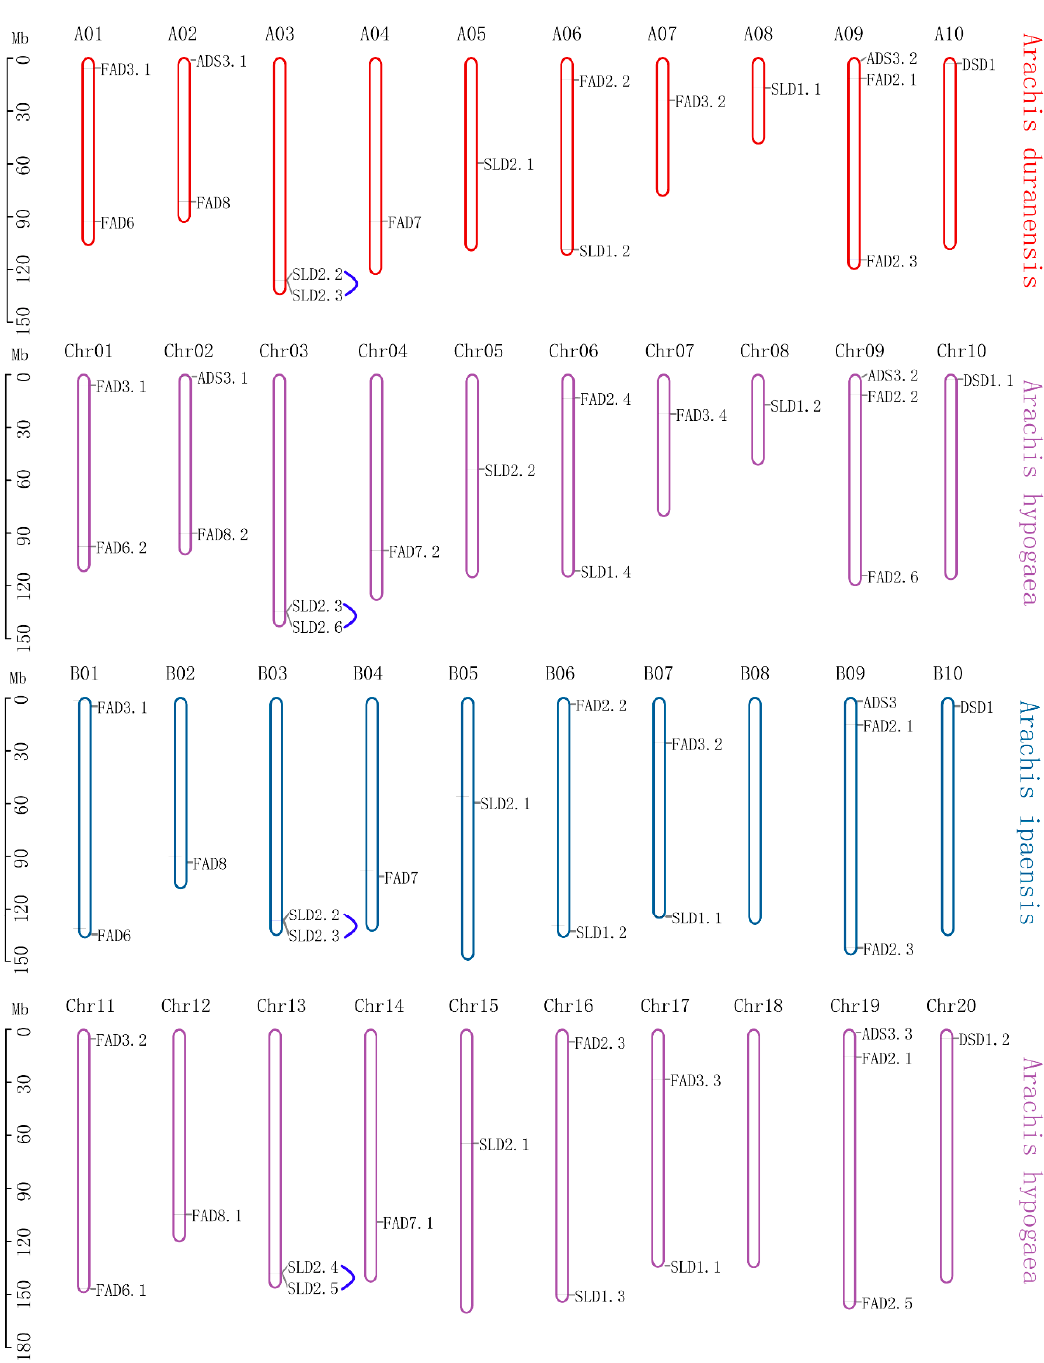
Figure 3. Chromosome distribution of FAD genes in three peanut species.